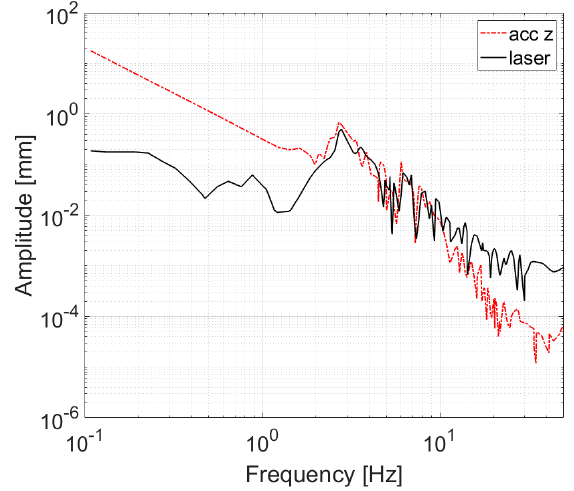
Figure 3. Example of vehicle vertical displacement spectrum while moving.